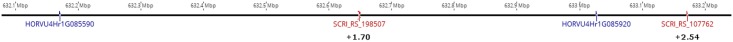
Physical map of the QTL region 4H-111.3cM including both candidate genes.The position of the two most significant SNP markers is indicated as well as their wild allele effects on the hairiness score.